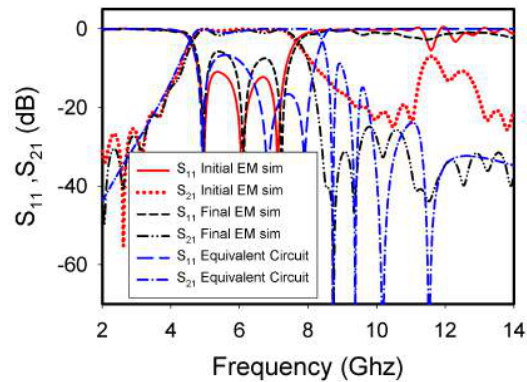
Figure 10: Frequency responses of the conventional and the